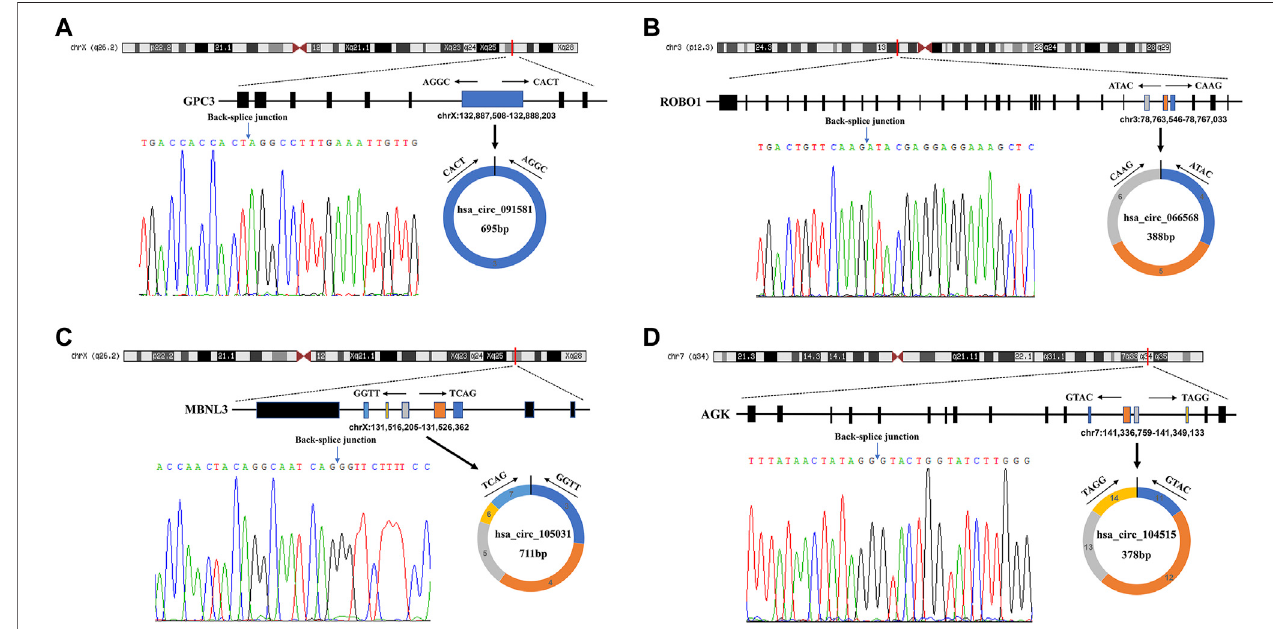
FIGURE 5 | The detailed information of the four circRNAs and their PCR products ’ back-splicing junction sites. (A) hsa_circRNA_091581. (B) hsa_circRNA_066568. (C) hsa_circRNA_105031. (D) hsa_circRNA_104515. PCR, polymerase chain reaction.